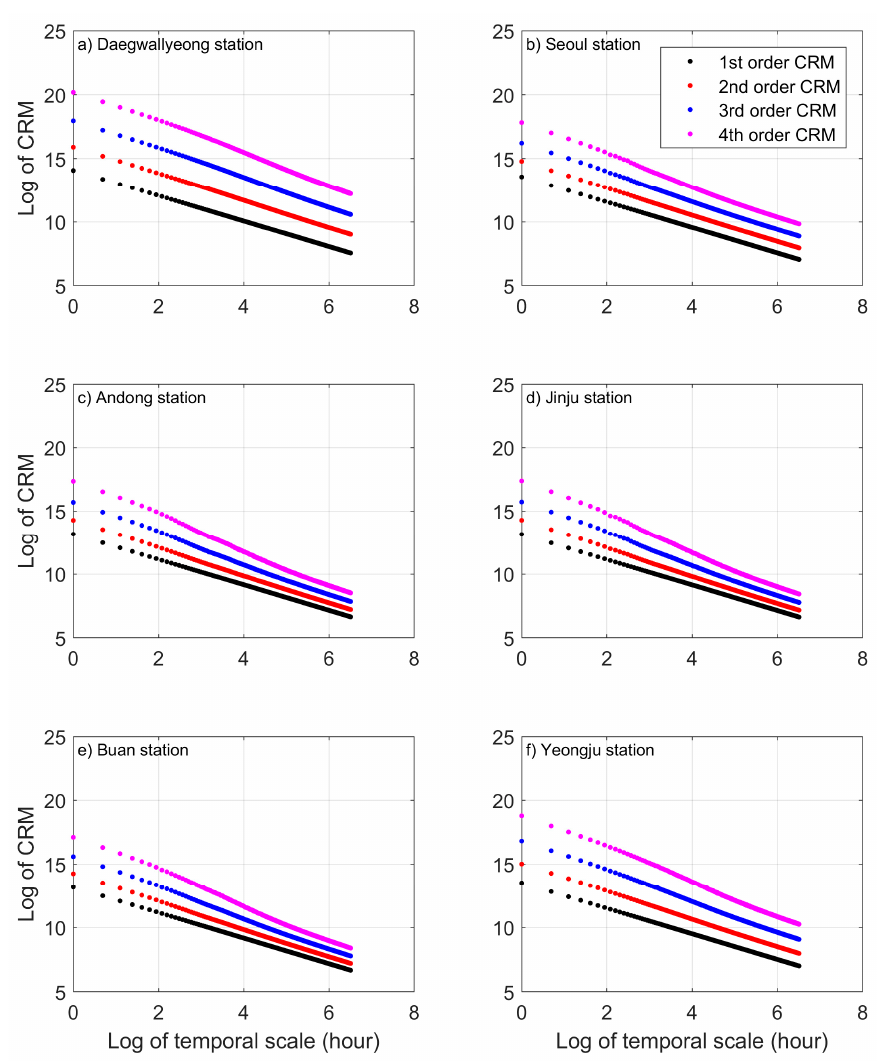
Figure 1. Plot of the log of the CRMs of wind speed and log of the temporal scales for the 1st- to 4th-order CRMs of six stations: ( a ) Daegwallyeong, ( b ) Seoul, ( c ) Andong, ( d ) Jinju, ( e ) Buan, ( f ) Yeongju stations.